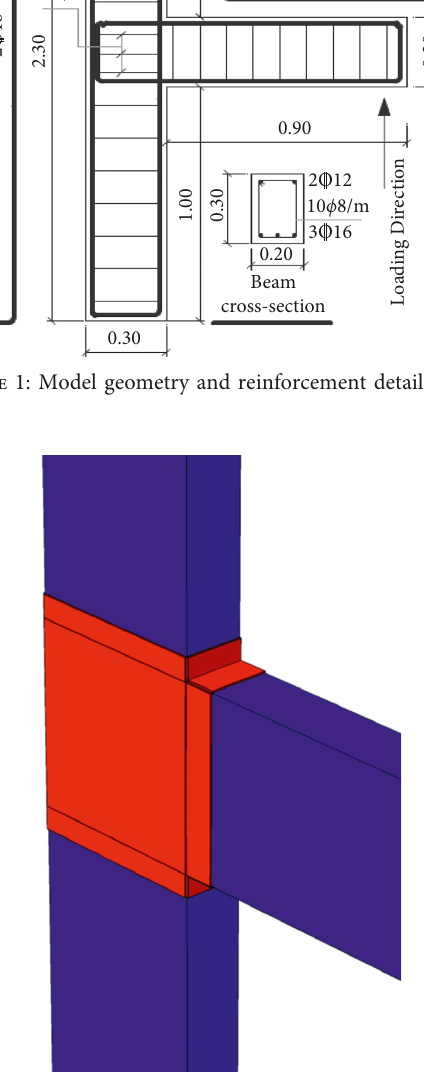
Figure 2: Textile reinforced cement model geometry at the